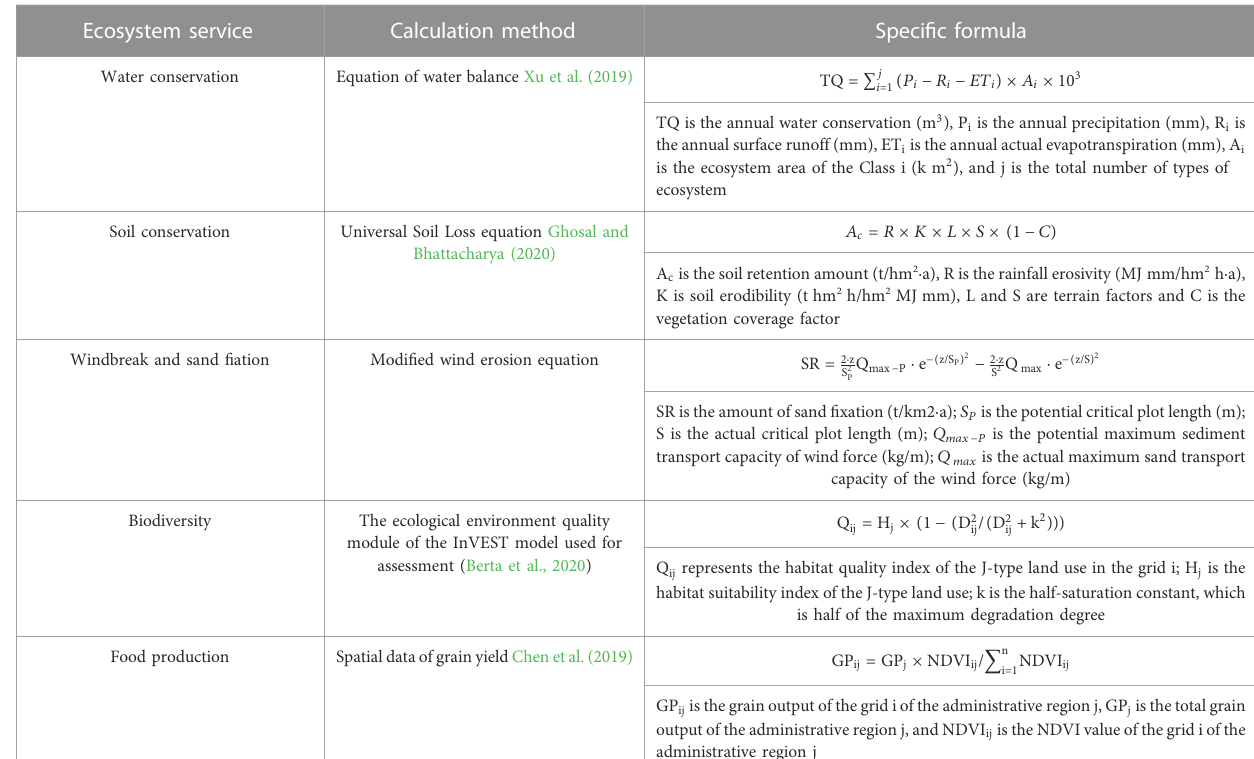
TABLE 3 Comprehensive assessment index and weight of ecosystem